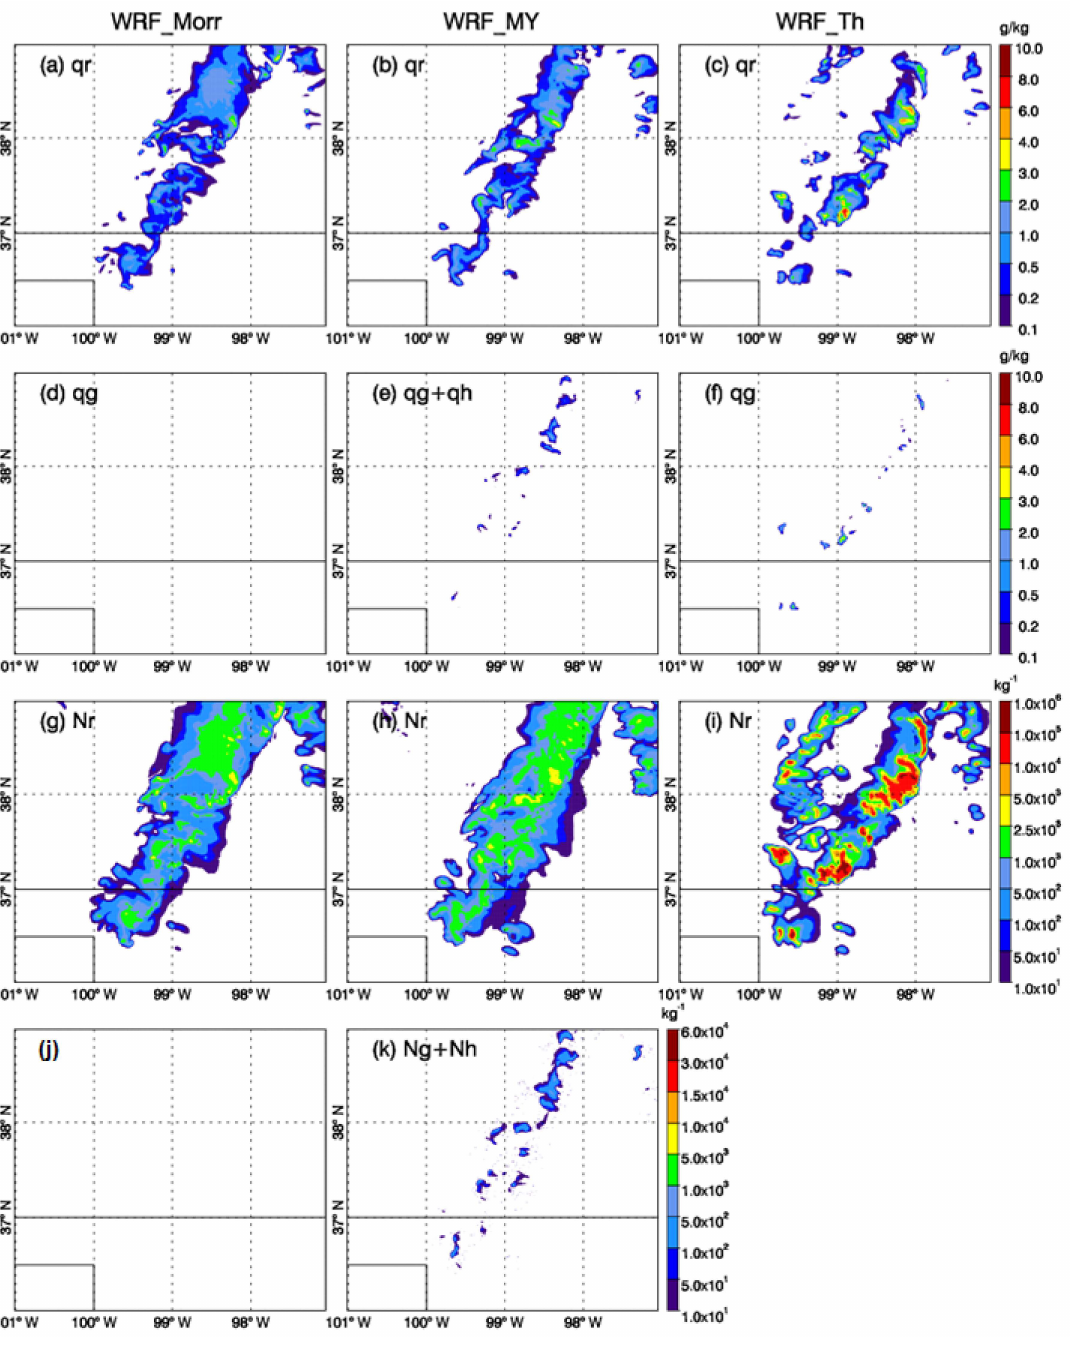
Figure 4. Mixing ratio of rainwater ( a – c ) and graupel or hail ( d – f ) for WRF_Morr, WRF_MY, and WRF_Th, respectively. Total number concentration of rainwater ( g – i ) for WRF_Morr, WRF_MY, and WRF_Th, respectively. Graupel or hail number concentration for ( j ) WRF_Morr and ( k ) WRF_MY. All plots are for the fields at 2345 UTC 29 May 2018 at 1 km